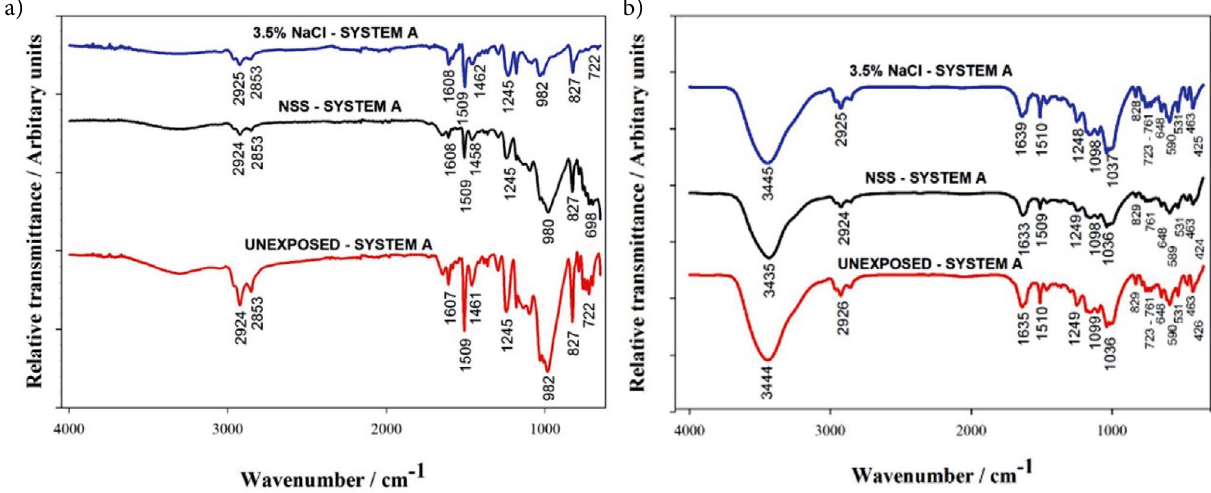
Figure 6. Spectra for system A before and after exposure to NSS and 3.5% NaCl tests obtained a) by the ATR FTIR method and b) from KBr pellets containing the scraped powder form the sample surface.